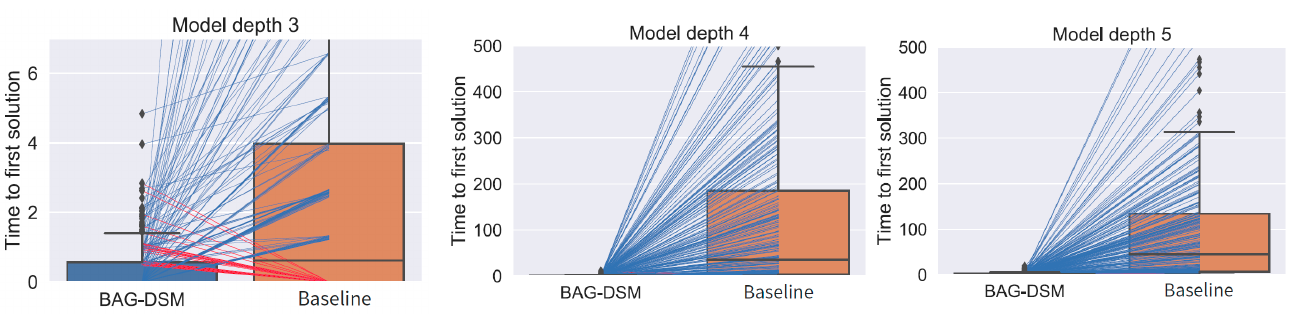
Figure 11. Paired boxplots for the distances (shorter is better) between the current alternative and the optimal alternative found by BAG-DSM (Bayesian) vs. baseline for decision support models with a depth of 3, 4, and 5. The horizontal lines connect two experimental runs with the same experimental setup.